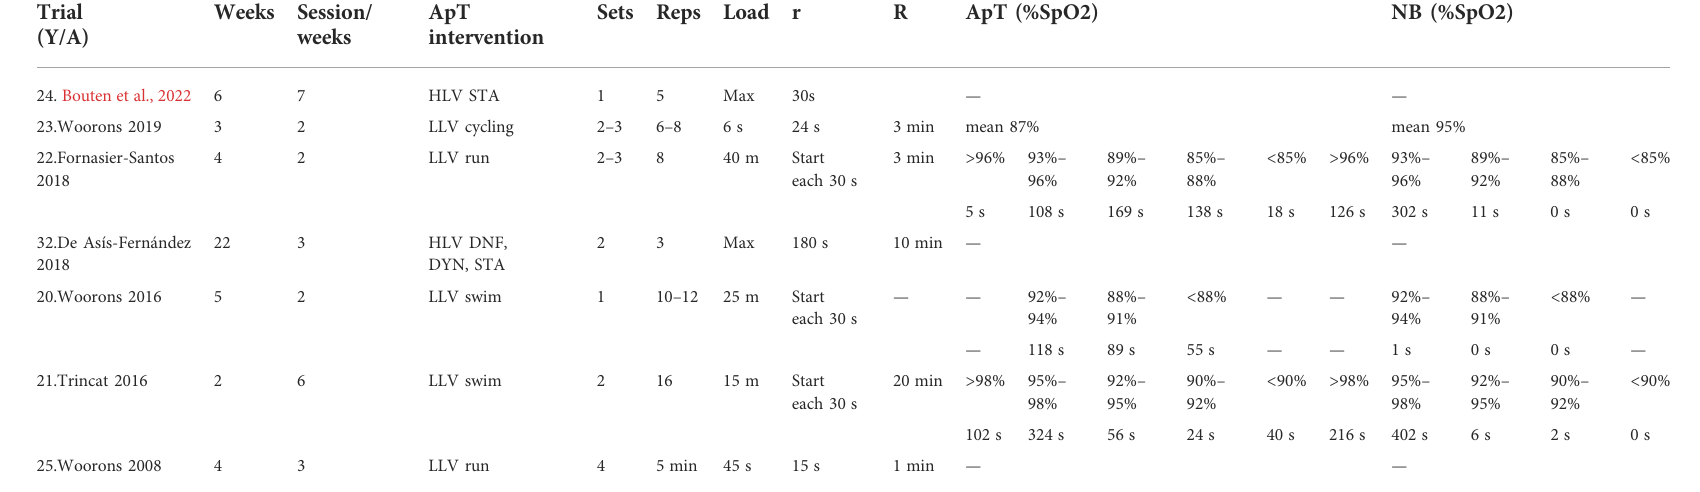
TABLE3 Apnoea training interventions ofincluded studies. DNFdynamic apnoea no fi nsDYN dynamic apnoea with fi ns, HLV DNF, DYN,STA dynamic apnoea no fi ns,dynamic apnoea fi nsand static apnoeaat high lung volumes, LLV cycling apnoea cycling at low lung volumes, LLV run apnoea running at low lung volumes, LLV swim apnoea swimming at low lung volumes, r recovery between repetitions, R recovery between sets. Trial